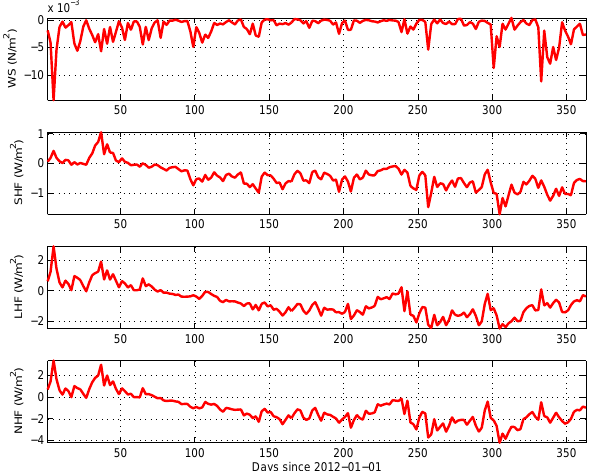
Figure 4. Top to bottom: wind stress, sensible, latent and net heat flux differences between the two experiments (BFC – BF). Negative sign indicates lower values for BFC in respect to